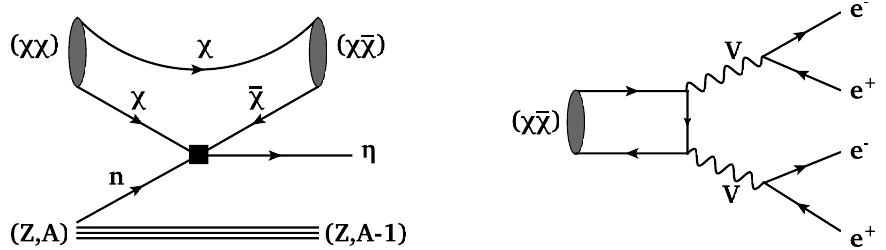
Figure 4 . Left : Feynman diagram for the scattering process ( (cid:31)(cid:31) ) + n ! ( (cid:31) (cid:22) (cid:31) ) + (cid:17) in the model described in section 5. Right : A possible way of destructing the ( (cid:31) (cid:22) (cid:31) ) bound state after the scat-